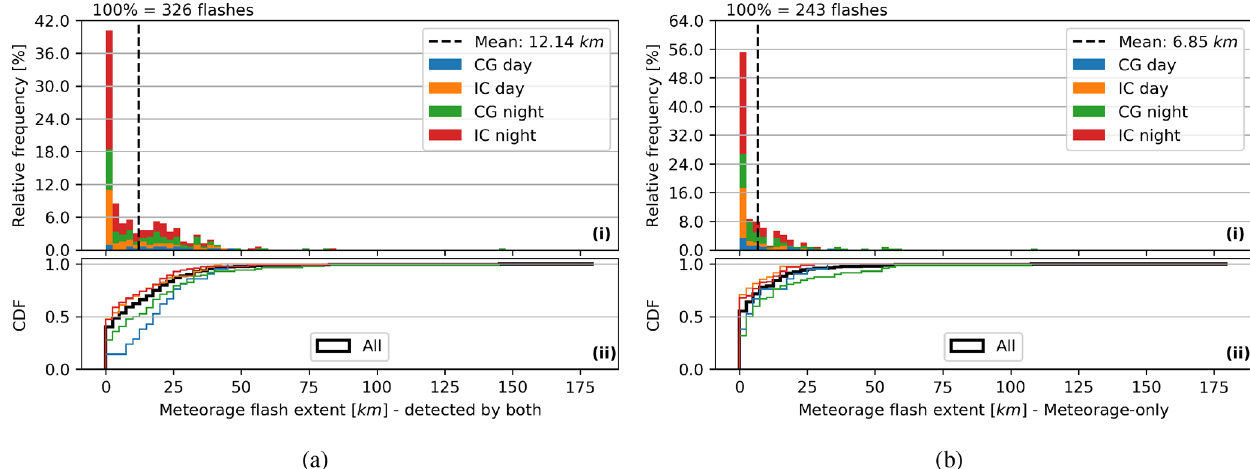
Figure 11. Flash extent of Meteorage flashes with a coincident ISS-LIS flash (a) and unmatched Meteorage flashes (b) . Daytime, nighttime and flash type, IC and CG, are indicated by the colors. The histogram (i) and corresponding CDF (ii) use the same colors. The CDF additionally shows a black curve for all data. The histogram bin width is constant at 2.5km. The mean value is plotted as a dashed line. The total number of flashes is indicated above the histogram.